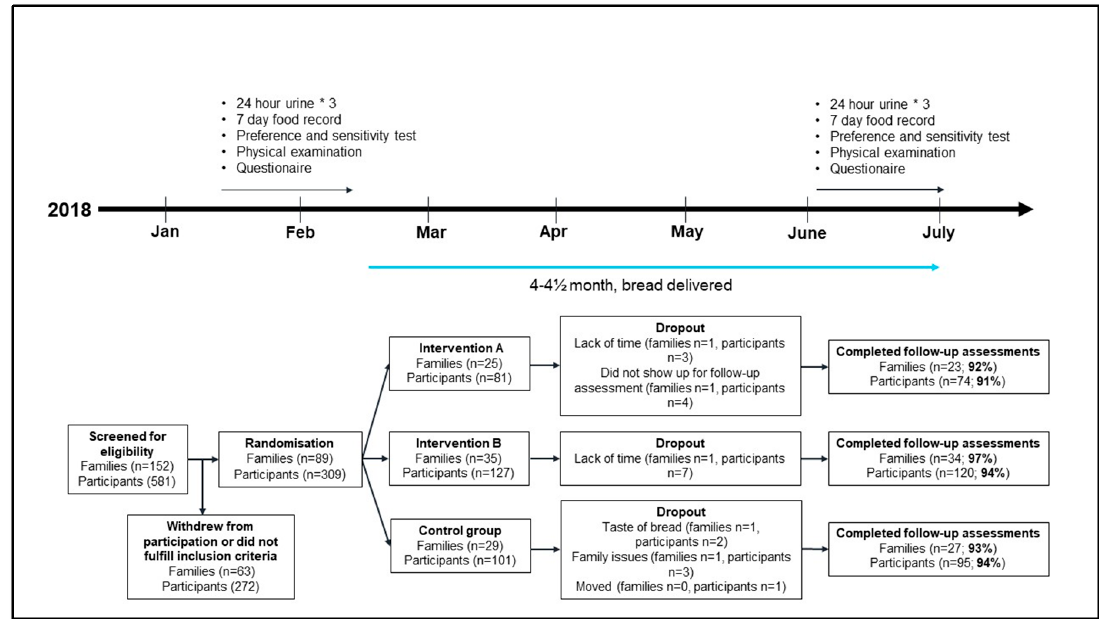
Figure 1. Design and flowchart.